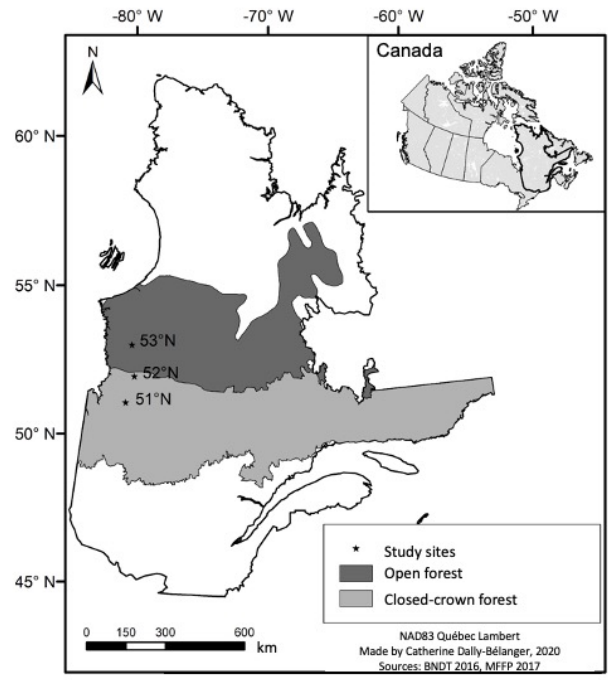
Figure 1. Study area and localization of the experimental plots in the boreal forest of eastern